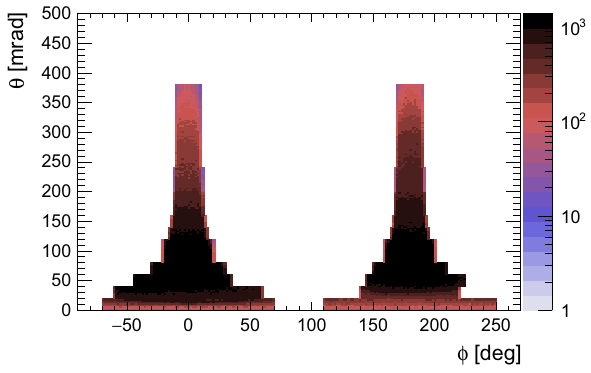
Fig. 6 The θ − φ distribution of selected tracks: regions of flat accep- tance are selected. The selected regions in azimuthal angle φ depend on the polar angle θ interval